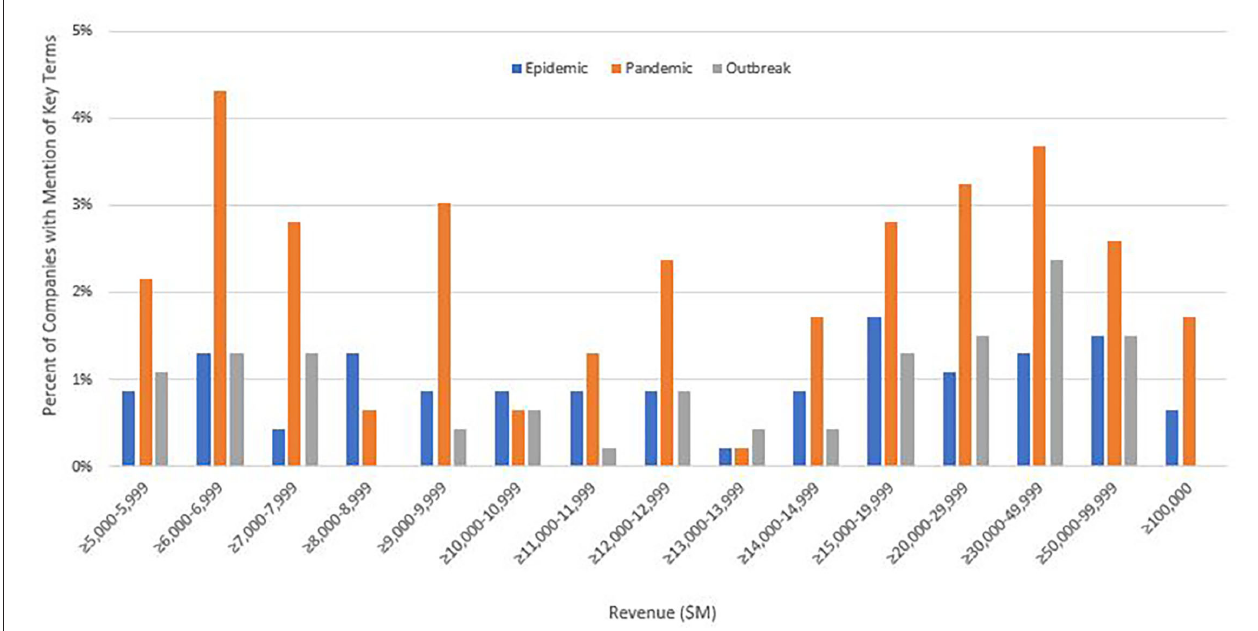
FIGURE 1 | Percent of 2018 Fortune 500 companies with mention of epidemic, pandemic, and outbreak in the risk factor section of their 10-K filings by revenue. ≥ 5,000–5,999 ( N = 31), ≥ 6,000–6,999 ( N = 59), ≥ 7,000–7,999 ( N = 46), ≥ 8,000–8,999 ( N = 23), ≥ 9,000–9,999 ( N = 29), ≥ l0,000–10,999 ( N = 21). ≥ 11000–11,999 ( N = 19), ≥ 12,000–12,999 ( N = 30), ≥ 13,000–13,999 ( N = 11), ≥ 14,000–14,999 ( N = 21), ≥ 15000–19,999 ( N = 36), ≥ 20,000–29,999 ( N = 50), ≥ 30,000–49,999 ( N = 32), ≥ 50,000–99,999 ( N = 31), ≥ 100,000 ( N =